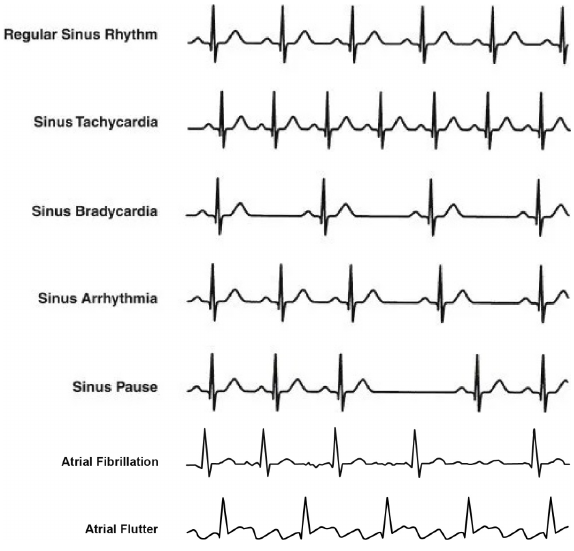
Figure 1. Types of